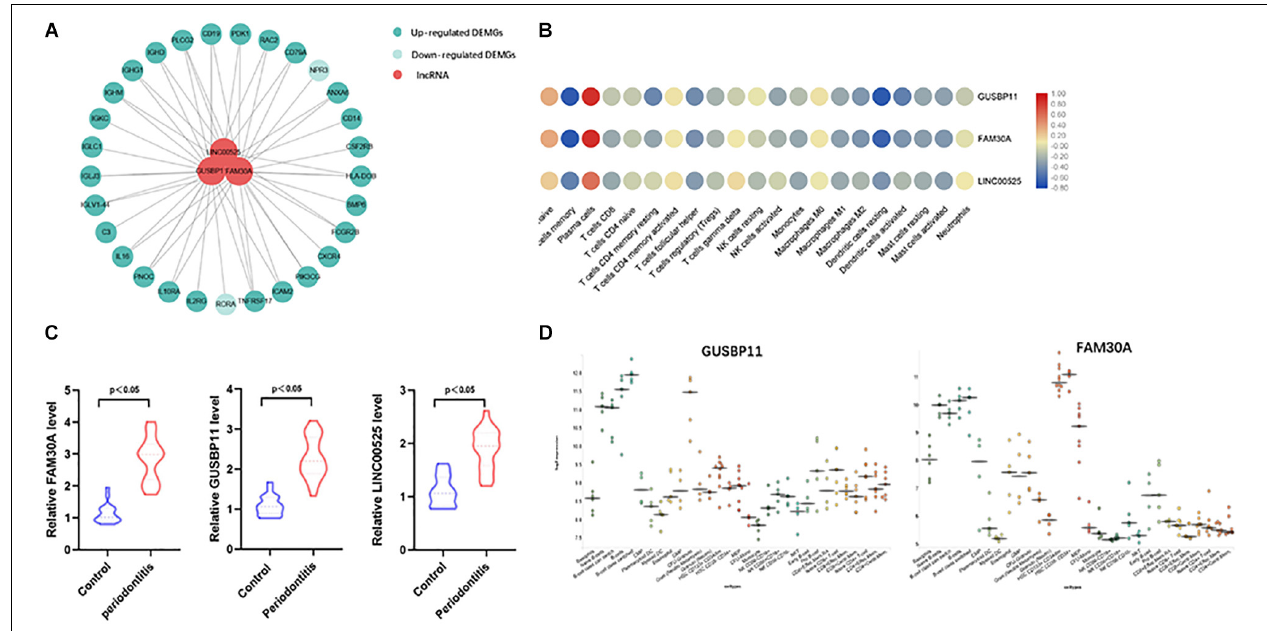
FIGURE 5 | Immune-related lncRNAs identified in immune cell types. (A) Network analysis between differentially expressed lncRNAs and immune-related genes in gingival tissues with or without periodontitis. The connection between immune cell types and immune-related lncRNAs means the correlation coefficient with | R| > 0.6 and P < 0.05. Three immune-related lncRNAs (FAM30A, GUSBP11, and LINC00525) were identified. (B) Correlation analysis between immune-related lncRNAs and immune cell subpopulations. (C) RT-PCR validation of immune-related lncRNAs (FAM30A, GUSBP11, and LINC00525); (D) FAM30A and GUSBP11 expression profiles in normal human immune cells. lncRNAs (FAM30A and GUSBP11) were highly expressed in B cells and their terminally differentiated offspring.